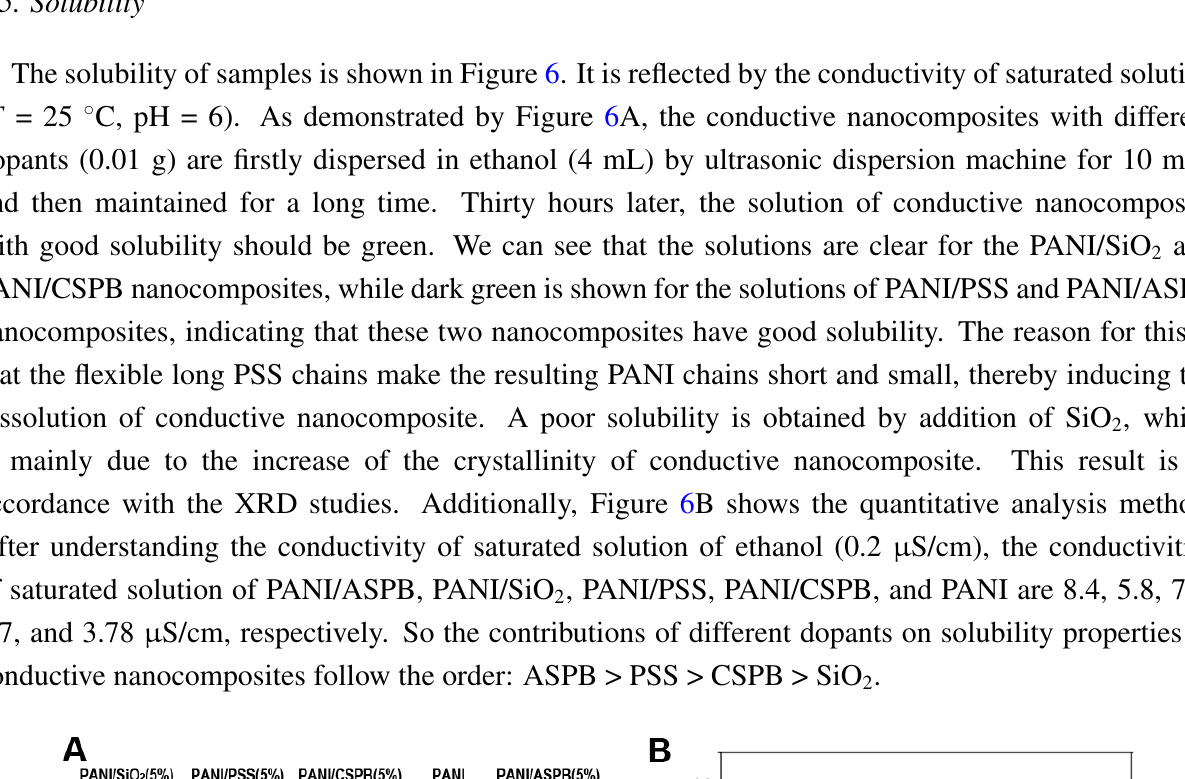
Figure 5. ( A ) TGA curves and ( B ) DSC curves of PANI, PANI/ASPB PANI/PSS, PANI/CSPB, and PANI/SiO 2 nanocomposites.